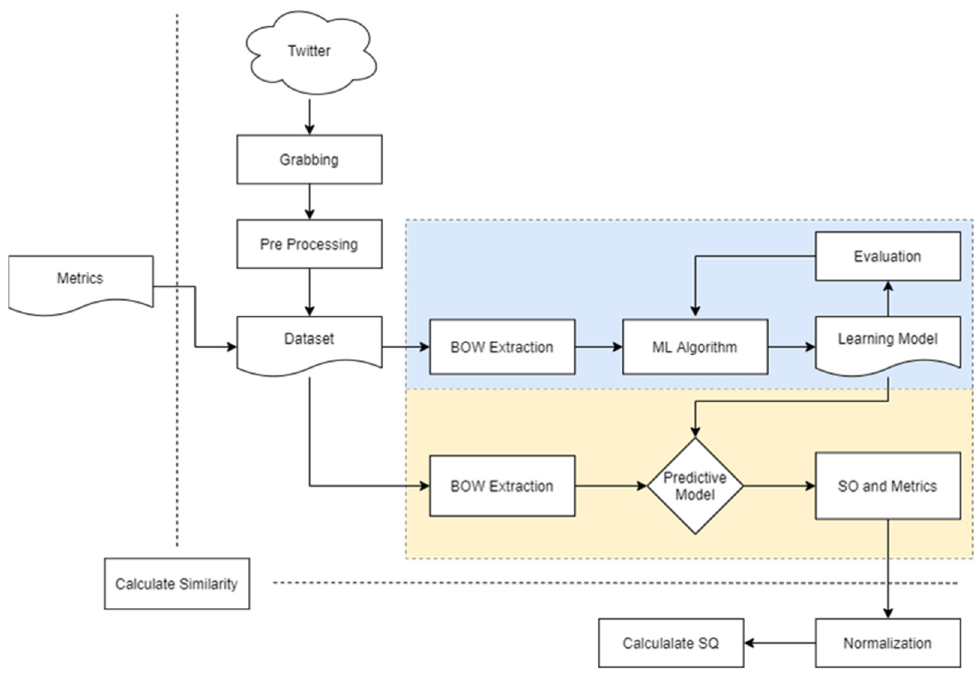
Figure 1. The framework of the service quality calculation.